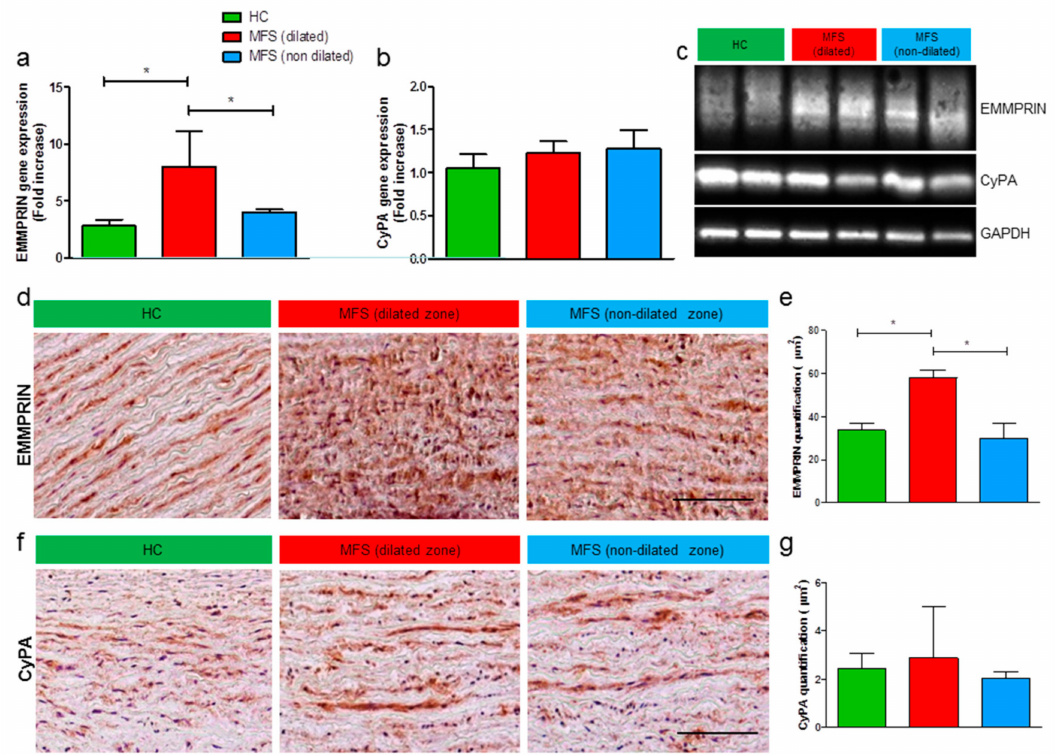
Figure 2. EMMPRIN expression levels are higher in the thoracic aorta of MFS patients. ( a , b ) EMMPRIN ( a ) and CyPA ( b ) gene expression in total RNA extracts of thoracic aortas from HC (green bars), MFS dilated (red bars) and MFS non-dilated zones (blue bars). qRT-PCR analyses were performed in triplicate and data are shown as fold change ± SD, n = 5. Student’s t -test: * p < 0.05. ( c ) Representative images of Western Blot analysis on EMMPRIN and CyPA in total protein extracts of thoracic aortas from HC (green bars), MFS dilated (red bars), and MFS non-dilated zones (blue bars). ( d – g ) Representative images of immunohistochemistry for EMMPRIN ( d ) and CyPA ( f ) on thoracic aorta of HC subjects (left panel) and MFS patients (dilated zone, central panel; non-dilated zone, right panel). Magnification = 20 × . Scale bar = 200 µ m. Quantification of immunohistochemistry for EMMPRIN ( e ) and CyPA ( g ) has been shown as mean ± SD, n = 5. Student’s t -test: * p <